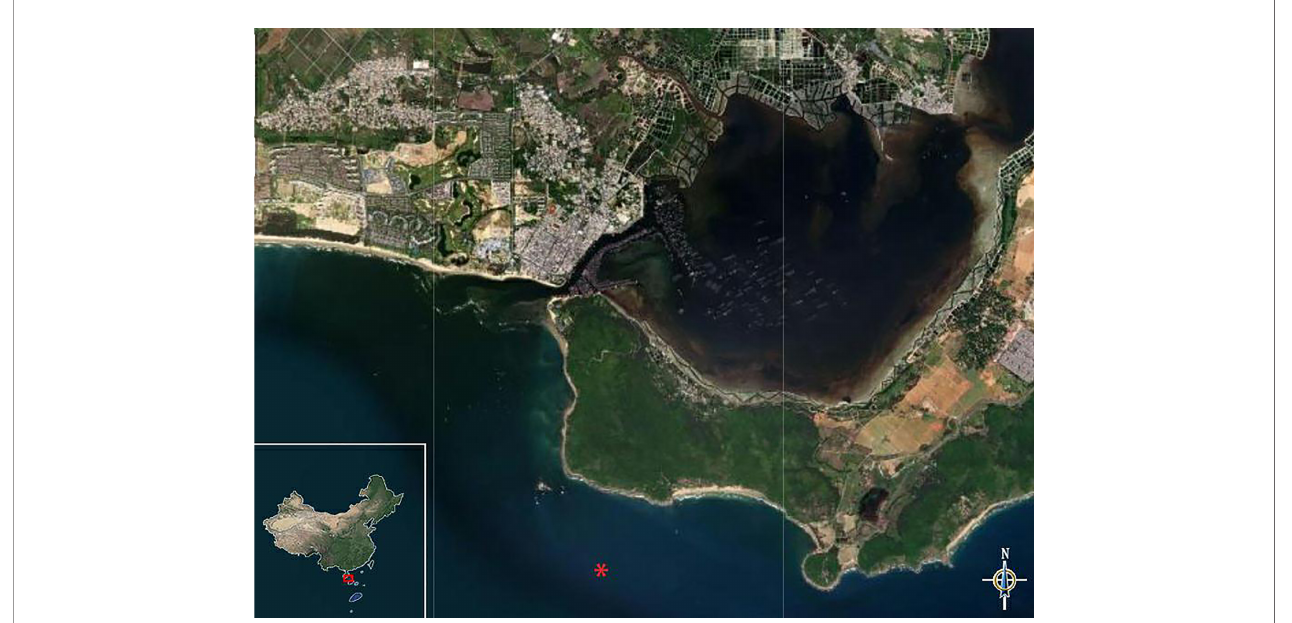
FIGURE 1 | Sampling point bitmap, the sampling point is “ * ” in the fi